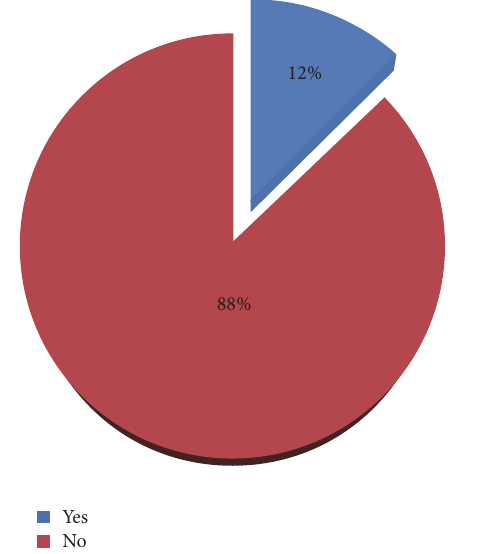
Figure 1: Distribution of family history of mental illness among residents of Gimbi town, 2014.